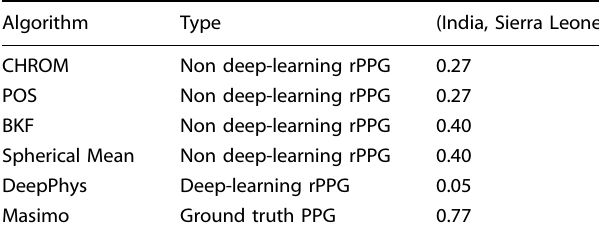
Table 6. Results ( p values) for hypothesis tests conducted across subjects of India and Sierra Leone for different rPPG approaches (test 15), compared to Masimo, after the removal of the outlier videos. Algorithm